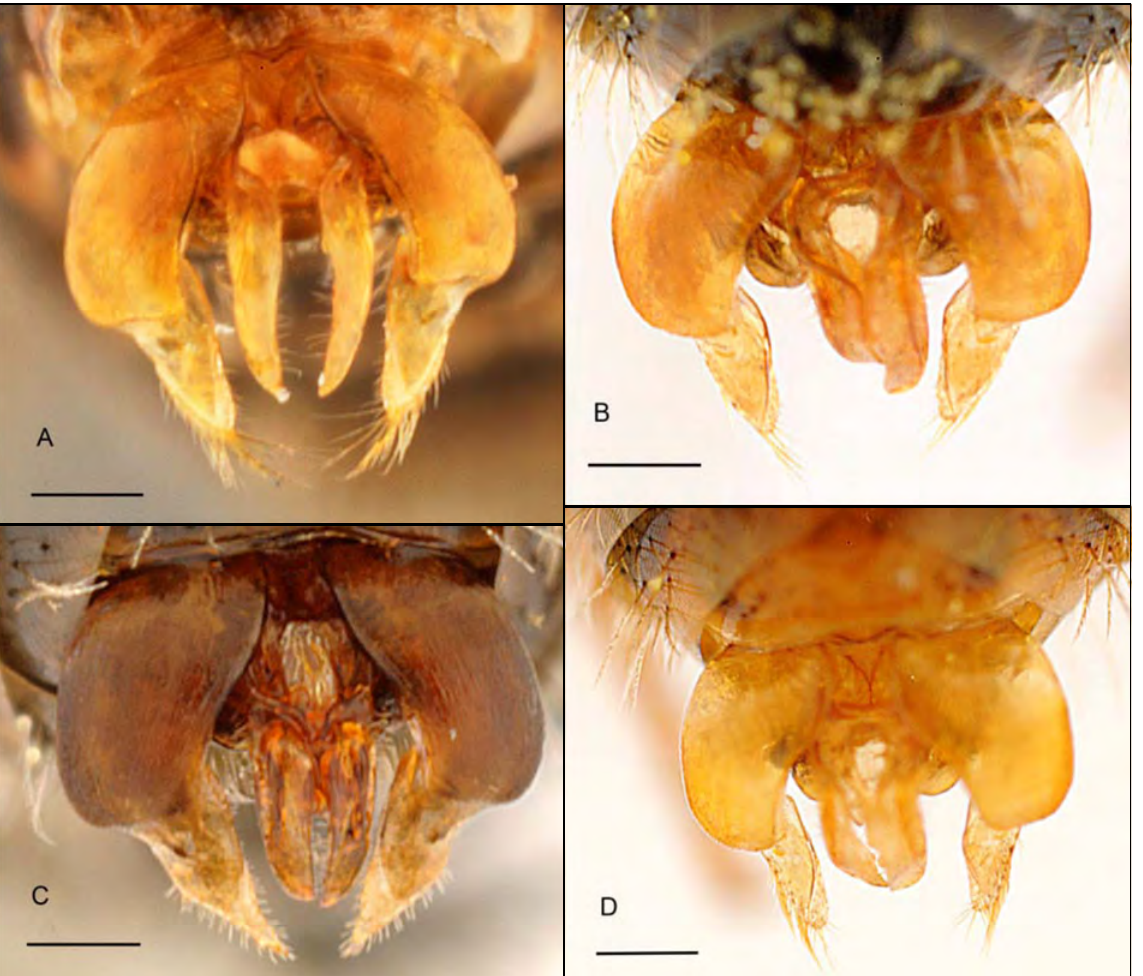
Fig. 15. ♂ genitalia, dorsal view. — A . Lasioglossum ( Capalictus ) mosselinum (Cockerell, 1945) . — B . Lasioglossum ( Capalictus ) timmermanni sp. nov. — C . Lasioglossum ( Capalictus ) hantamense sp. nov. — D . Lasioglossum ( Capalictus ) tigrinum sp. nov. Scale line = 0,25